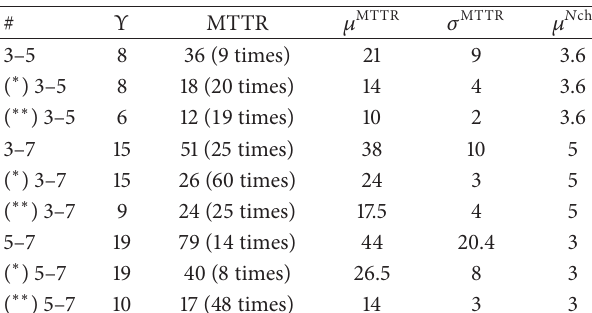
Table 6: A-ETCH in ACHv with 𝑆 0 sequence combinations for 𝑁 = 3, 5, 7 ; ( 𝑟, 𝑛) = {(3,21) , (5,55) , (7,105)}